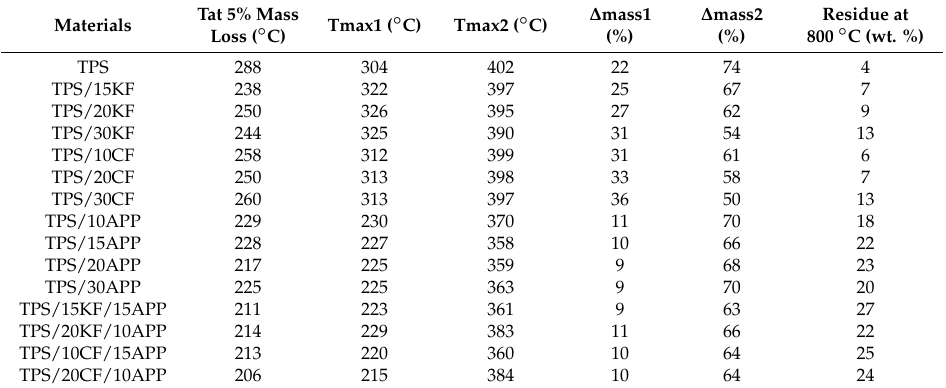
Table 3. Thermogravimetry results for all formulations.